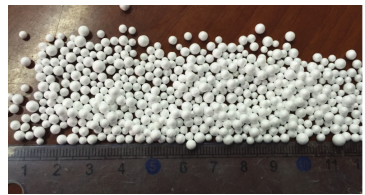
Figure 1: Expanded polystyrene spheres.